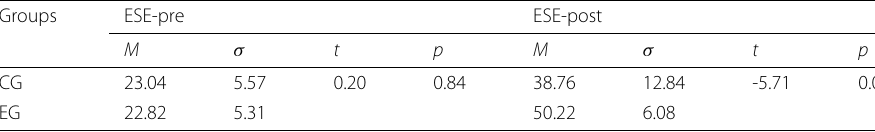
Table 4 t -statistics of experimental self-efficacy and test groups